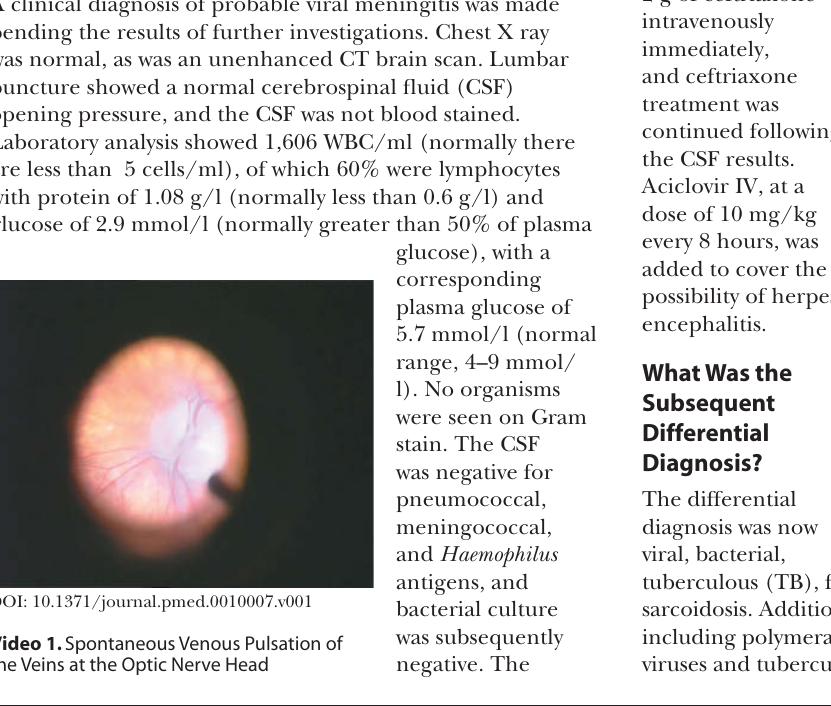
Table 1. CSF Changes in the Most Commonly Encountered Types of Meningitis Type of